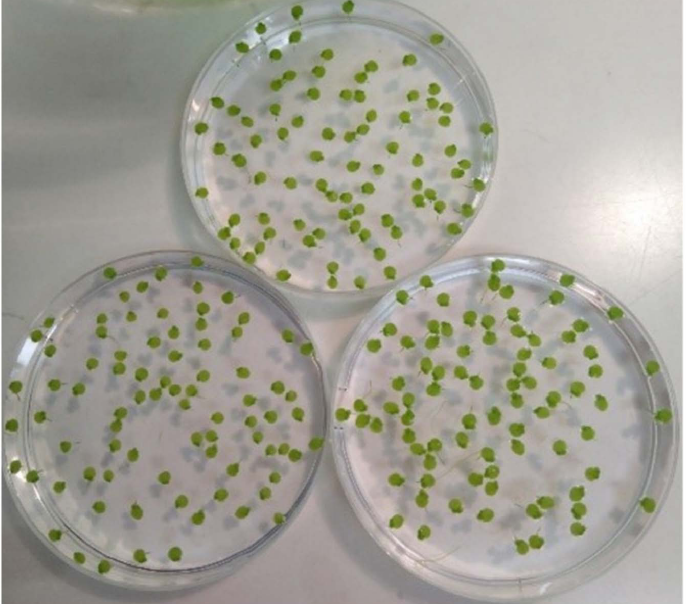
Figure 2. Sorting of duckweed prior to an experiment. Three groups of 85 fronds each were sorted. Duckweed fronds within each group had to be as similar as possible concerning symmetry and surface area. Additionally, fronds had to be non-chlorotic (whitening of the plant caused by the degradation of chlorophyll) and showing new small roots and daughter fronds. Figure 2 shows sorted plants stressed with 250 mg/L AsNa 2 HO 4 for 48